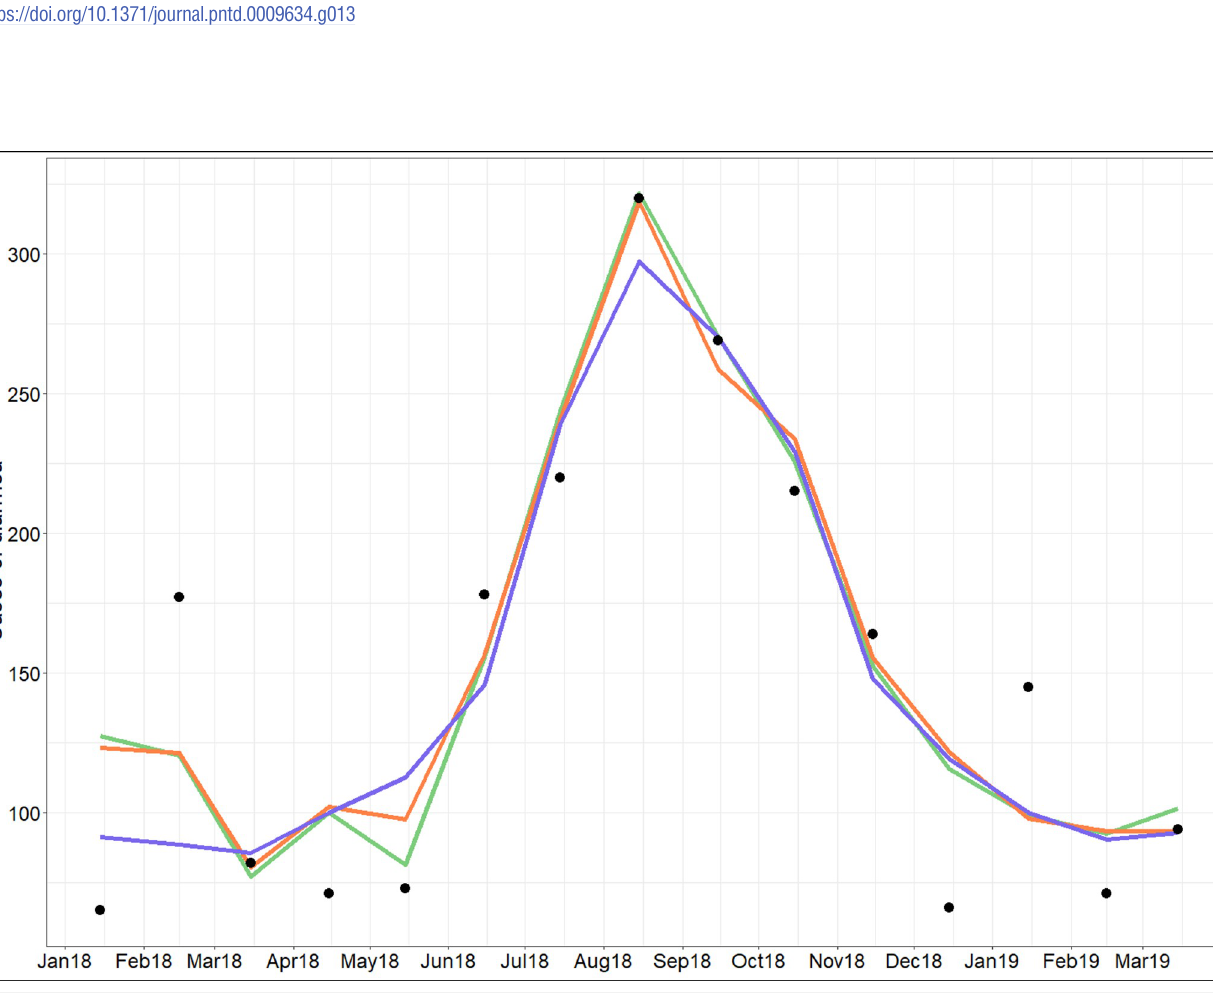
PLOS NeglectedTropical Diseases | https://doi.org/10.1371/journal.pntd.0009634 August 17, 2021 21 /